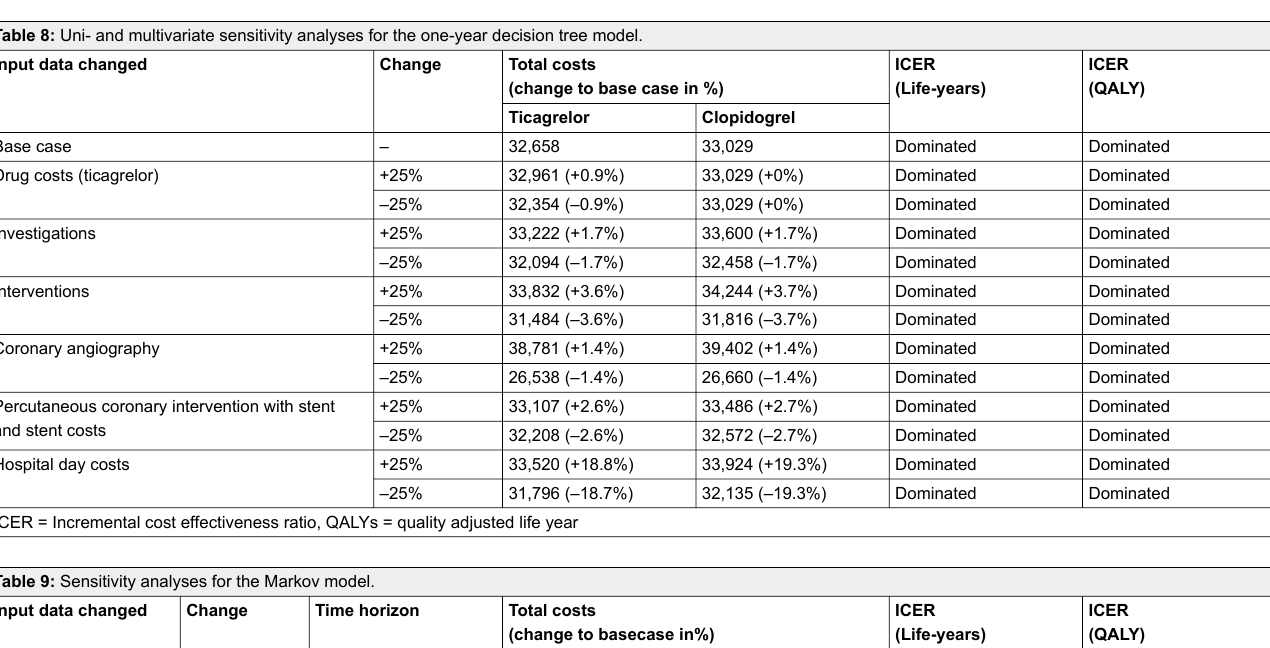
Table 8: Uni- and multivariate sensitivity analyses for the one-year decision tree model.